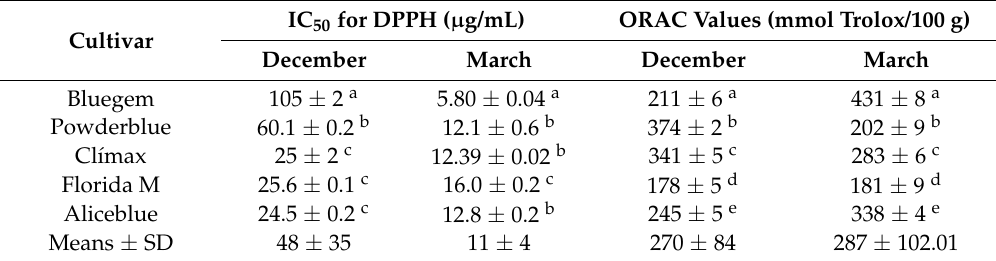
Table 3. Rabbiteye blueberry leaves antioxidant properties considering different harvesting months and cultivars by DPPH and ORAC methods IC 50 for DPPH ( µ g/mL) ORAC Values (mmol Trolox/100 Cultivar